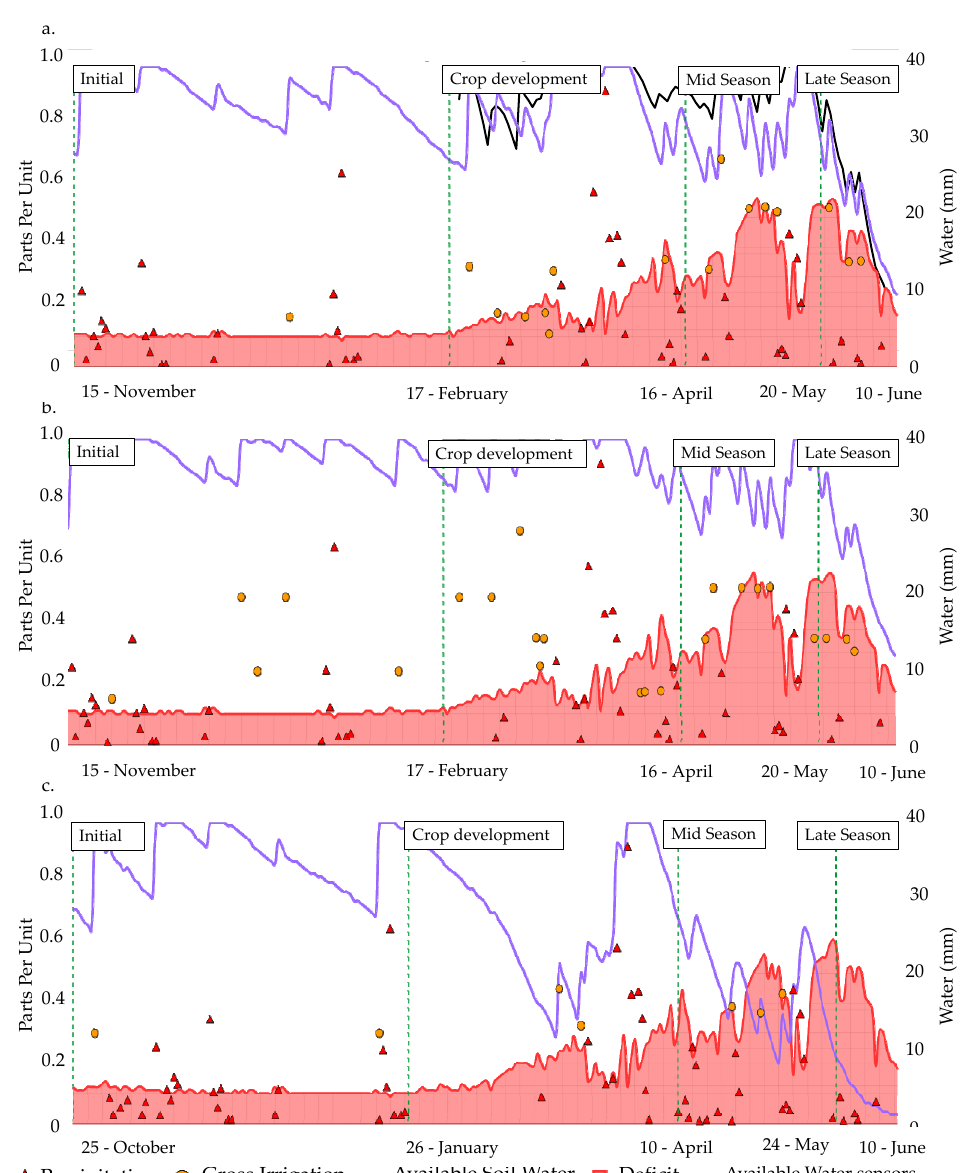
Figure 1. Evolution of available water simulated by “MOPECO irrigation scheduling” tool in 2020